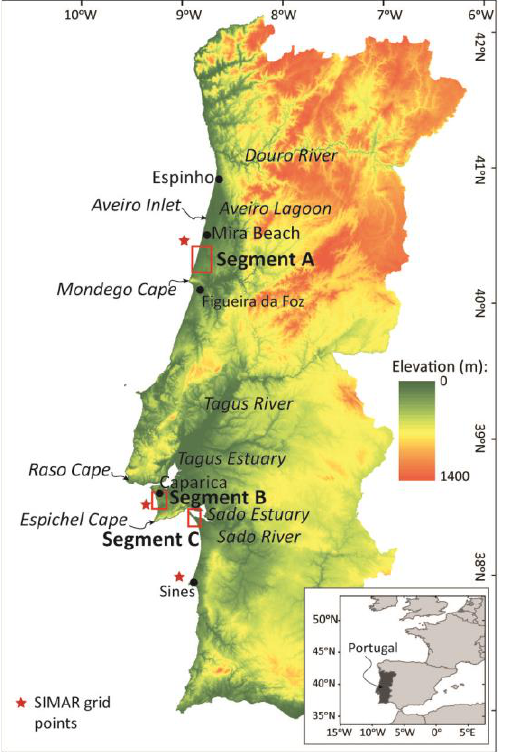
Figure 1. Location of the selected sites (Segments A to C) along the west coast of Portugal.